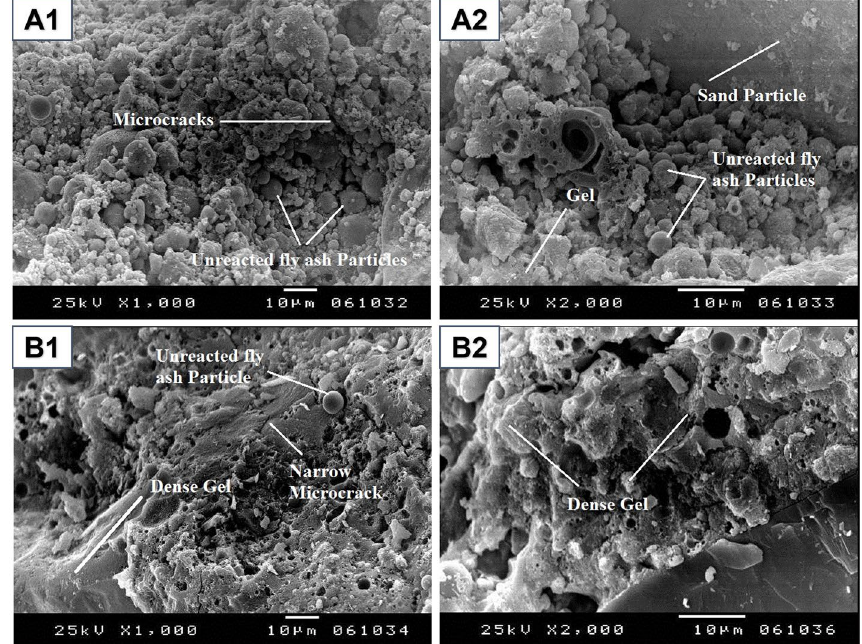
Fig. 11 A1 and A2 and B1 and B2 Represent SEM images for thermally cured FGPC and steam cured L-FGPC with 2% lime content at different scales. A1 Thermally cured FGPC using X1000. A2 Thermally cured FGPC using X2000. B1 Steam cured L-FGPC with 2% lime content using X1000. B2 Steam cured L-FGPC with